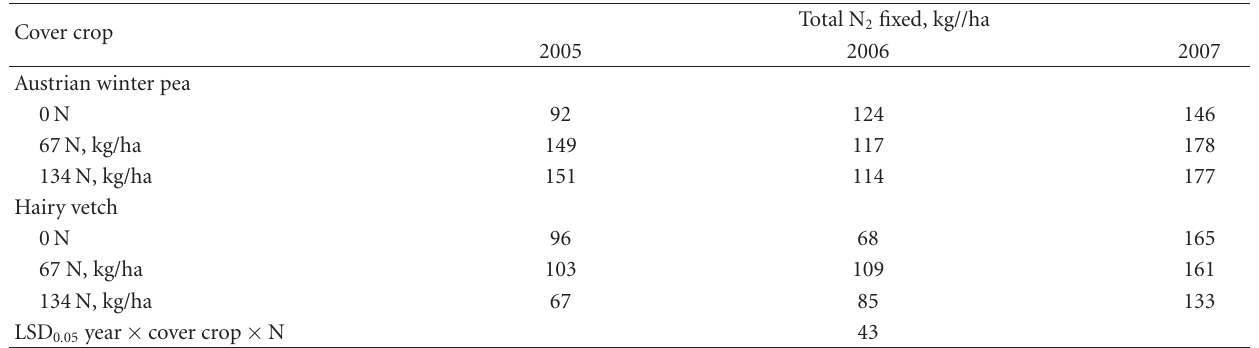
Table 3: Yearly estimates of total biological N fixed in above ground legume cover crop biomass before desiccation in 2005–2007. Cover crop